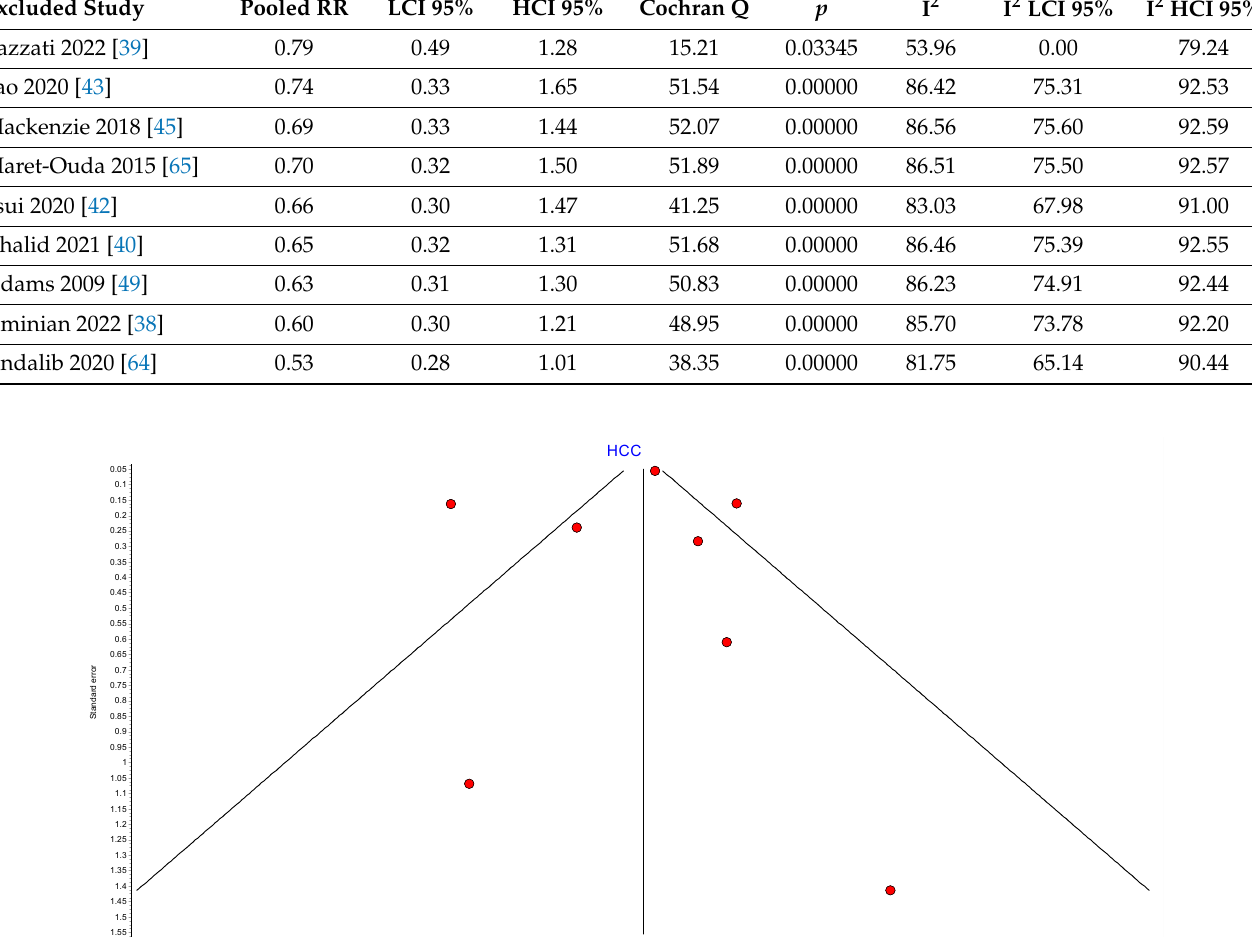
Figure A12. Oesophageal random effects model funnel plot. Table A12. Oesophageal random effects model sensitivity analysis.